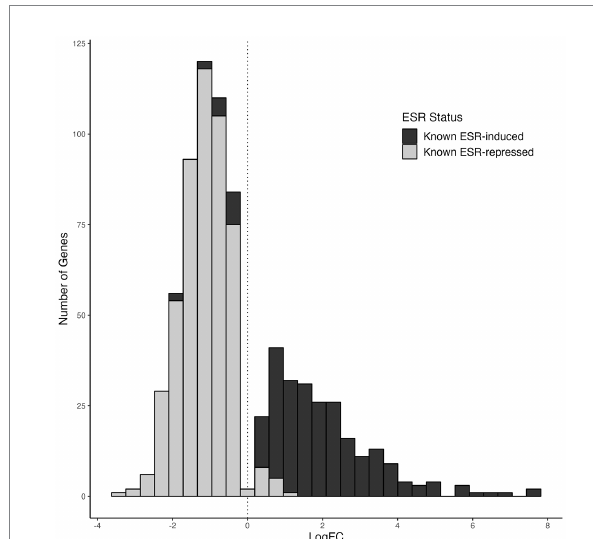
FIGURE 7 Expression distribution of known environmental stress-response (ESR) gene groups in the 2-phenylethanol-resistant strain C9. The gray columns show the previously known genes that are expected to be repressed under ESR, while the black columns show the previously known genes that are expected to be induced under ESR, according to Brauer et al. (2008).